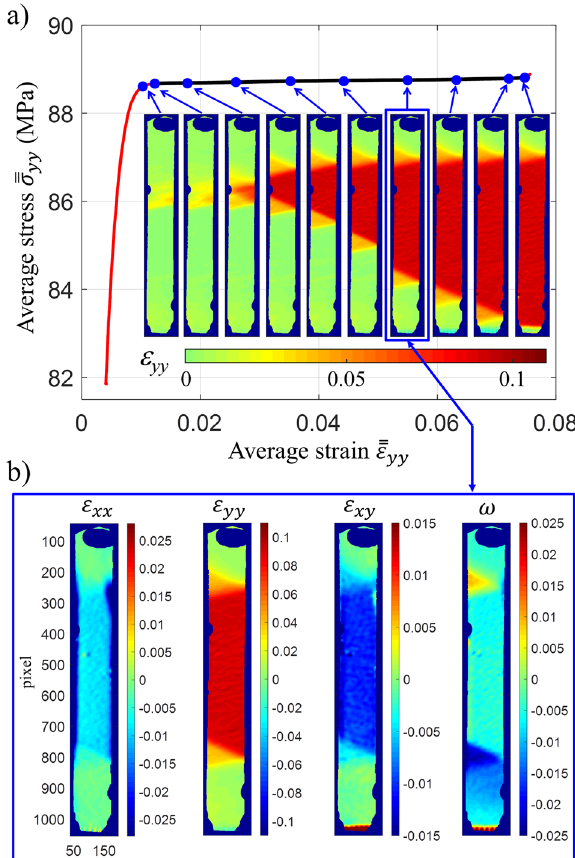
Fig. 2 Stress-strain curve and evolution of the strain fi eld. a The elastic part of the stress-strain curve is indicated in red and the transformation plateau in black. Snapshots of the map for the strain component ε yy are shown at various loading stages, marked by blue dots on the plateau. b Maps of all the in-plane strain components ε xx , ε xy , ε yy , and of the local rotation angle ω , corresponding to the average-strain value ε yy ¼ 0 : 052. See also Supplementary Movie